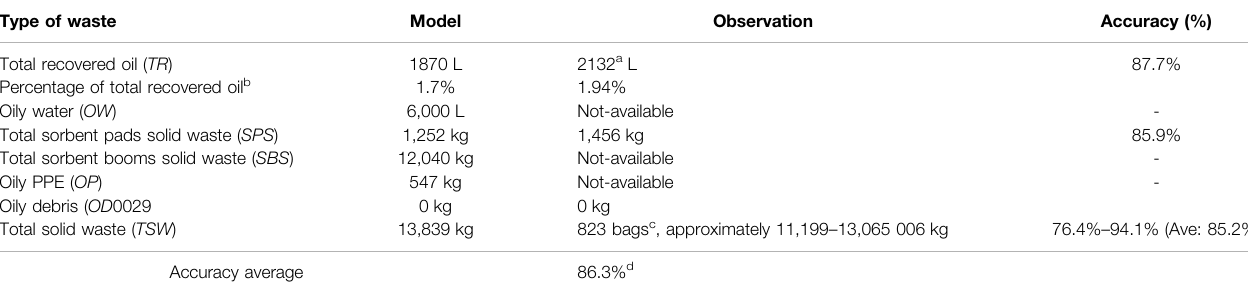
TABLE 3 | Comparing the results of the model and observation for the Bella Bella oil spill. Type of waste